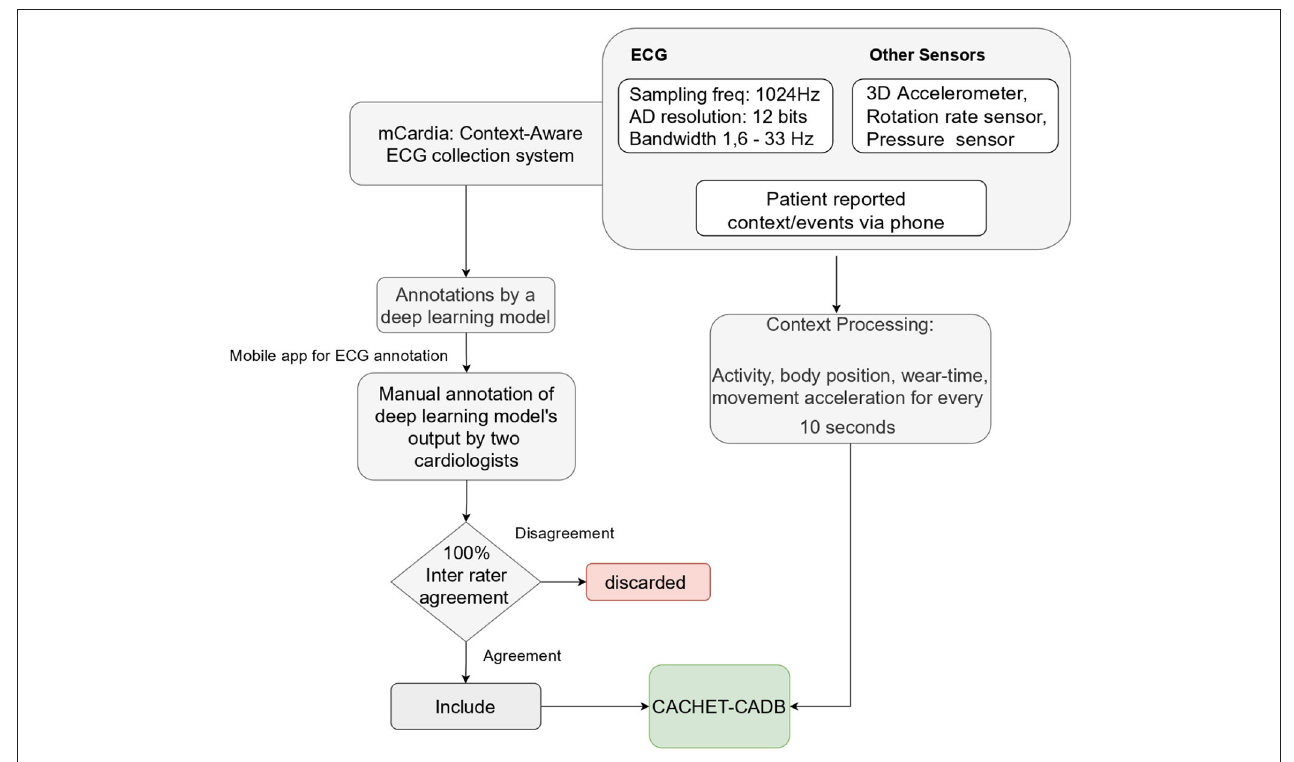
FIGURE 2 | Overview of data collection and annotation